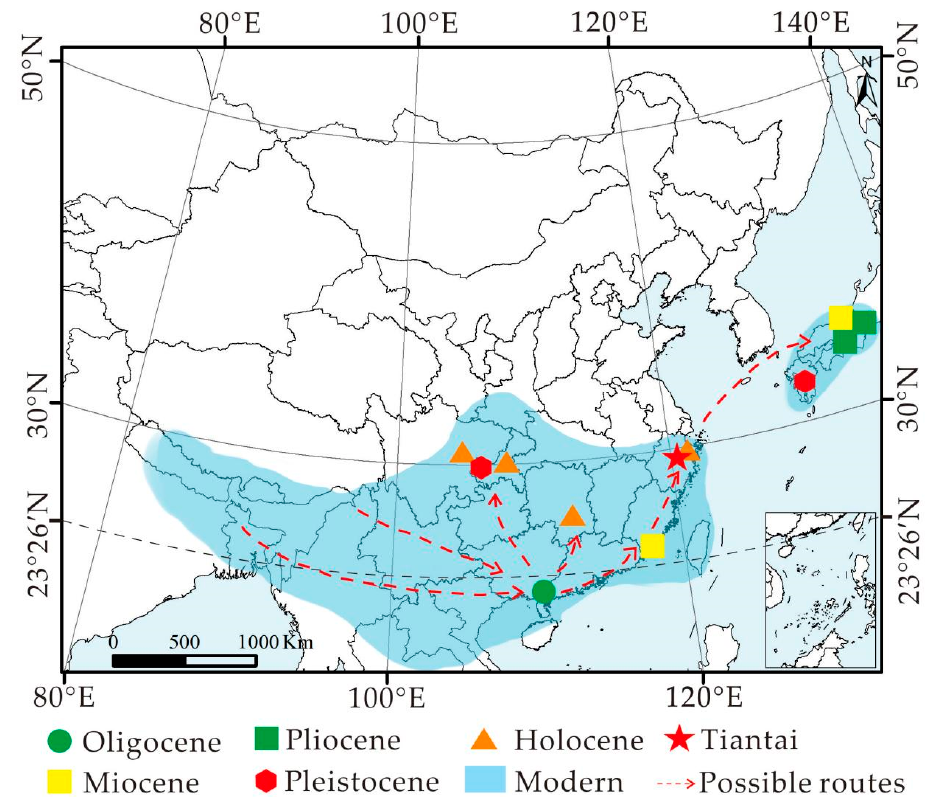
Figure 8. The fossil records and the present distribution range (representing in blue color) of Choerospondias in Asia. The red dotted line represents the dispersal route of Choerospondias in Asia. 4.2. Paleoclimatic Implications of the Current Choerospondias Fossils Extant Choerospondias axillaris is a deciduous tree that mainly grows in subtropical and tropical mountain forests with an elevation of 300–2000m, constituting minor components of subtropical to tropical evergreen forests in China [13,81–83]. Ye et al. [84] suggested that low temperature was a primary environmental factor influencing the distribution of the Choerospondias plant, followed by frost. Warm and humid climates are more favorable for the growth of Choerospondias [85]. Based on the living environments of extant Choerospondias , semiquantitative climatic parameters in the late Miocene eastern Zhejiang were obtained using the method of climate analysis of endemic species (CAES) [86,87], including the mean annual temperature (MAT) 5.7–24.7 °C, mean annual precipitation (MAP) 669–2435 mm, mean temperature of the warmest month (MTWM) 14.2–29.9 °C, and mean temperature of the coldest month (MTCM) − 4.1–19.8 °C. To obtain more accurate MAT and MAP values, Ye et al. [84] used the MaxEnt model to reconstruct the two climatic values based on the distribution area of living Choerospondias plants, the MAT of 12.3 to 25.5 °C and the MAP of 950 to 2700 mm, respectively. The paleoclimatic parameters were further compared with the data reconstructed in previous studies.